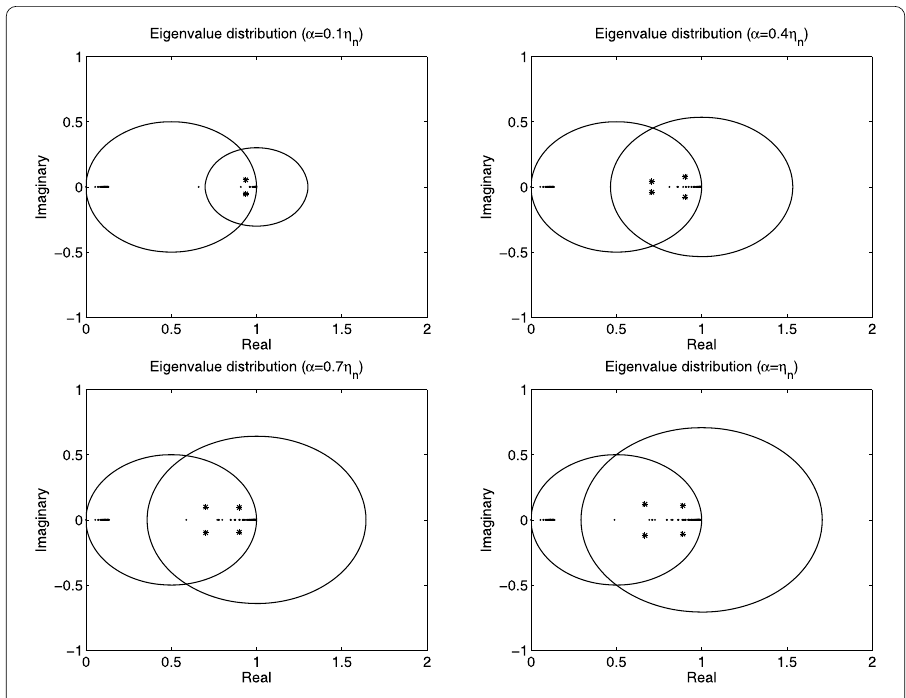
A for Example 3.1. SS